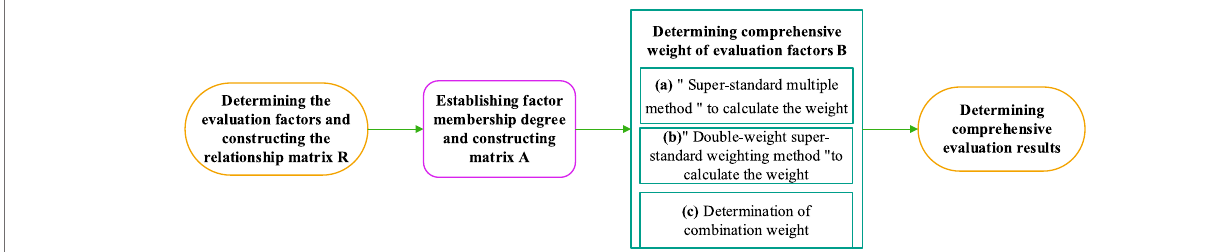
FIGURE 1 | The framework of evaluation method.